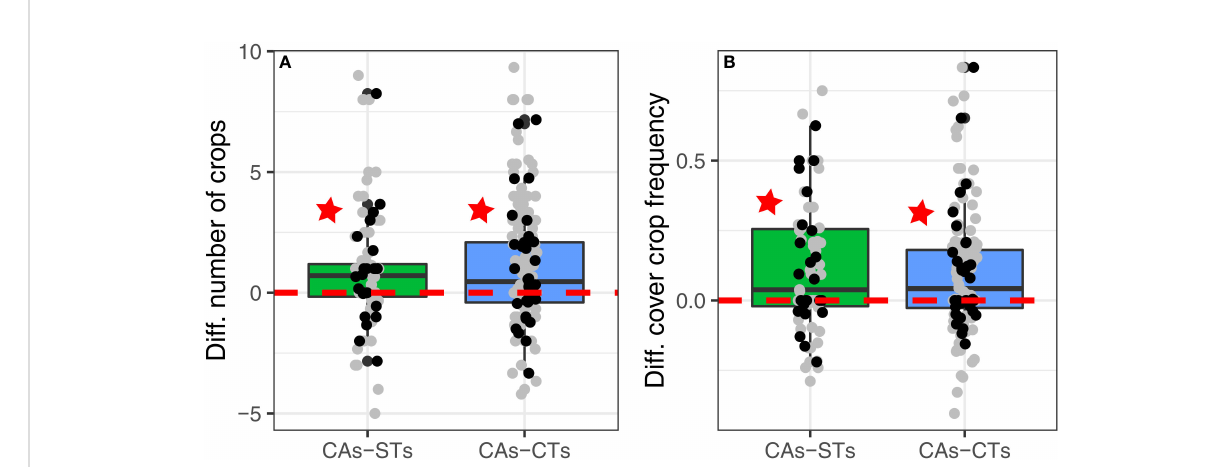
FIGURE 2 Distributions of the differences in response variables between conservation agriculture systems (CAs) and their reference conventional tillage (CTs, blue boxplots) and super fi cial tillage (STs, green boxplots) based systems for: the number of crops (A) and the frequency of fallow cover crops (B) . Grey dots represent individual differences between systems. Black dots represent average differences per cluster. Red stars indicate signi fi cant differences between CAs and its reference system (either CTs or STs) at p<0.05, cluster accounting for the production situation included as a random effect in the model (see details in Table